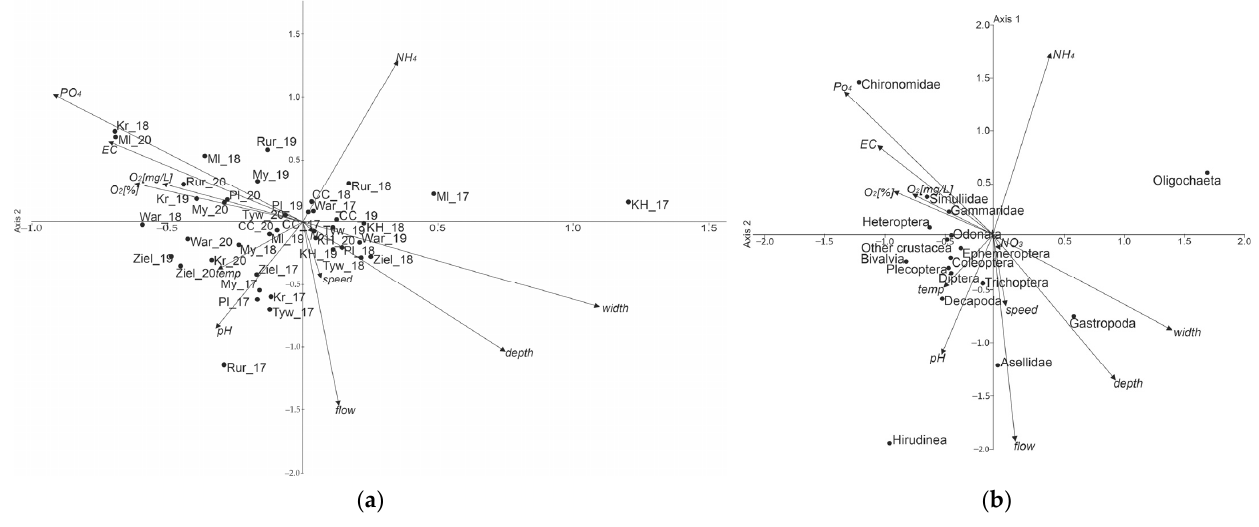
Figure 4. CCA graph for the surveyed sites: ( a ) sites, ( b ) taxa. Table 4. Eigenvalues, % of explained variation and p value estimates for the first four of the 12 axes shown by CCA.